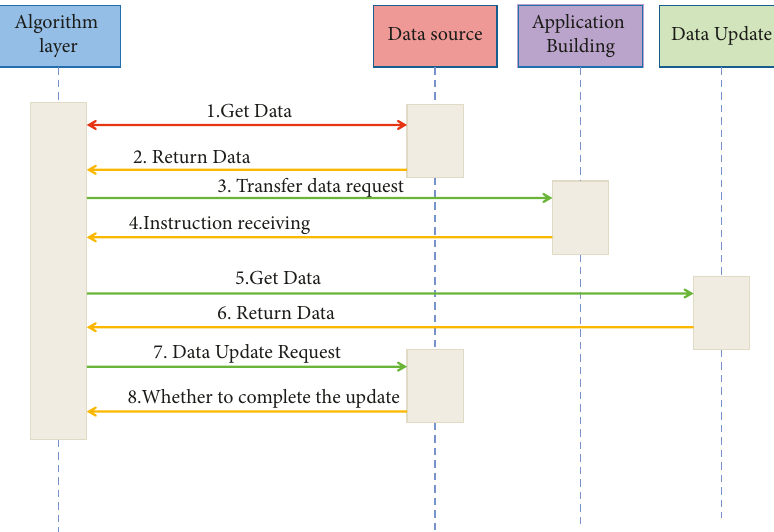
Figure 5: Circuit update